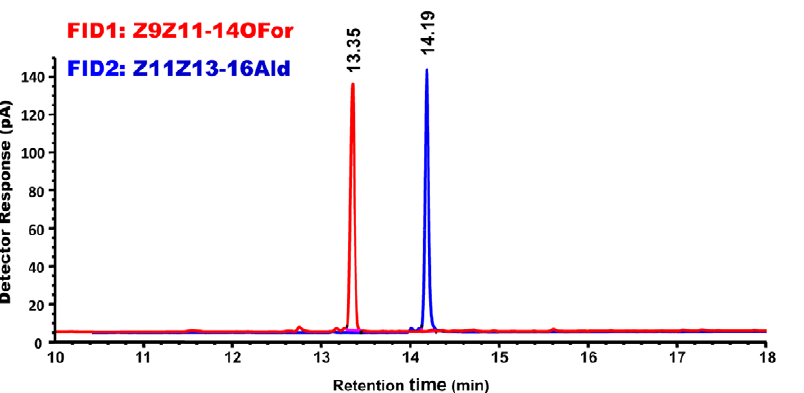
Figure 7. Gas chromatographic traces obtained with extracts of the odorants used to stimulate receptor-expressing oocytes. The peaks of the formate analog and the related aldehyde pheromone are of nearly the same intensity thus confirming that oocytes are stimulated with nearly the same concentrations of the two compounds.